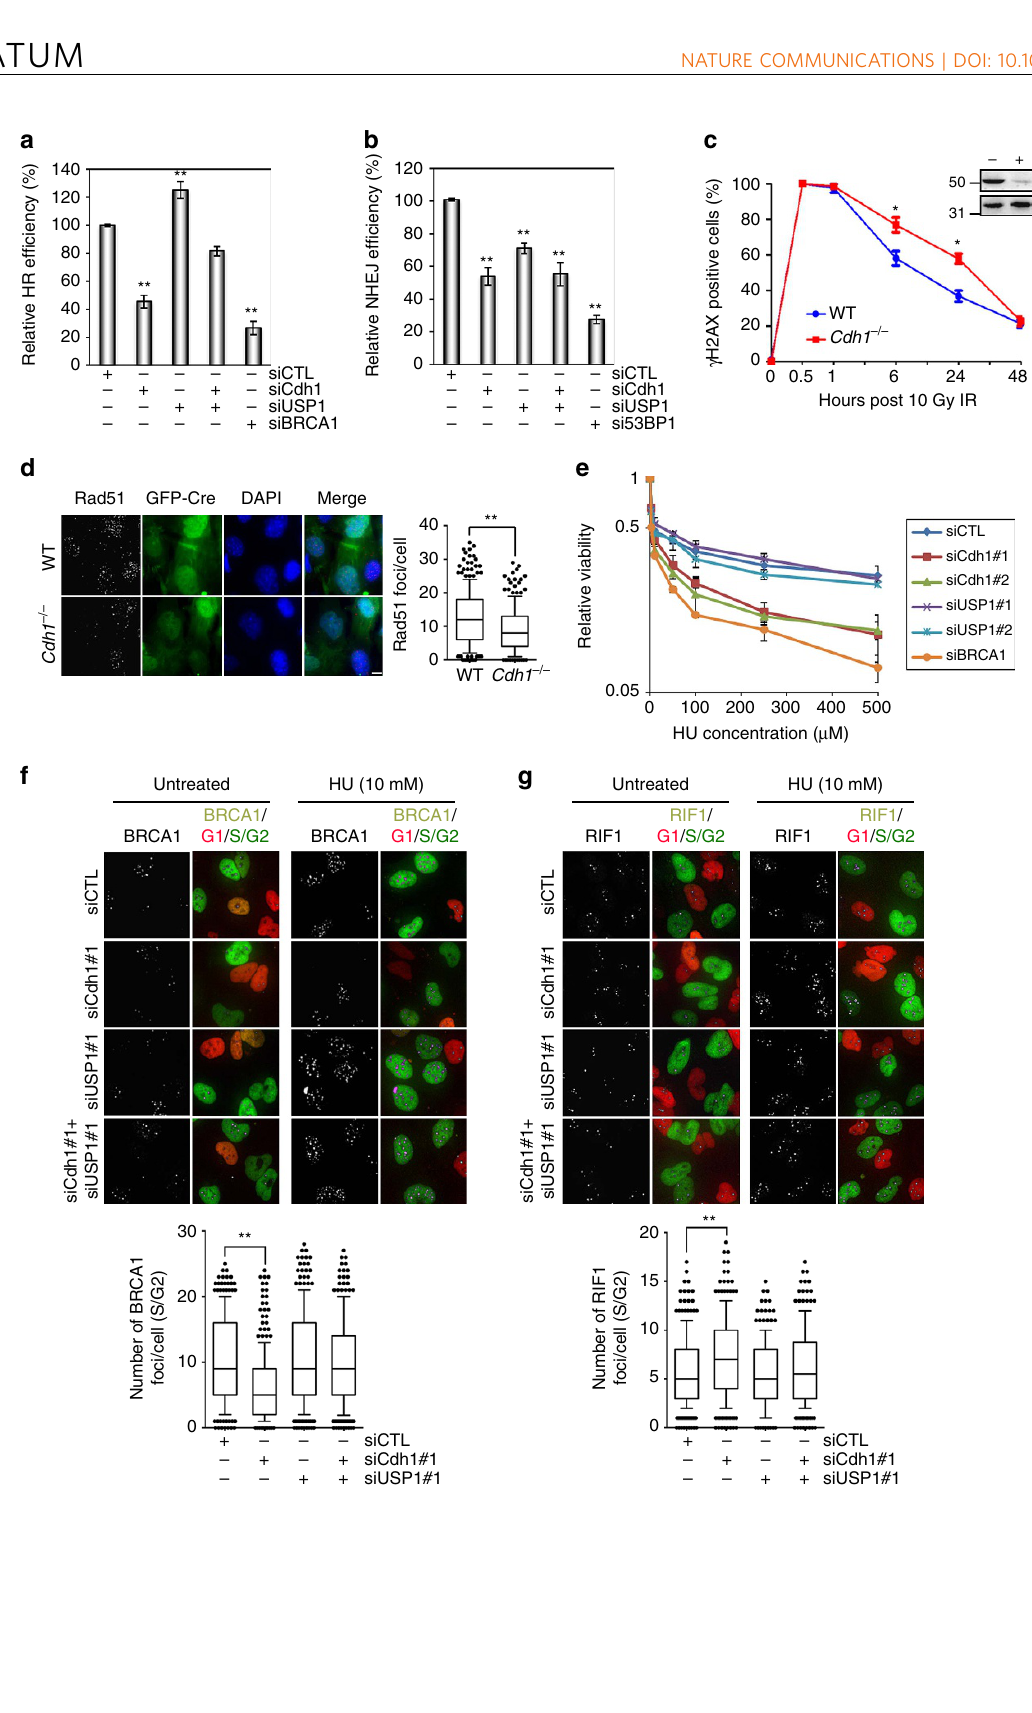
2 NATURE COMMUNICATIONS|8:16156|DOI: